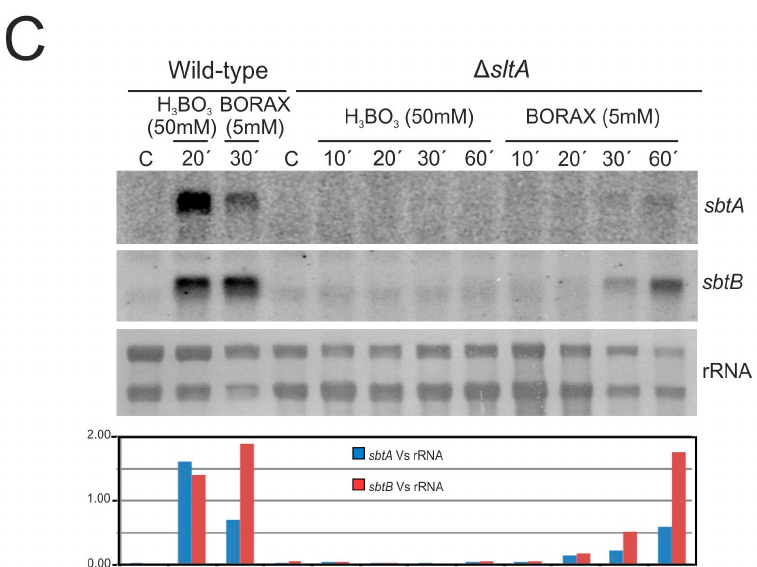
Figure 6. Transcriptional control of sbtA/B expression by SltA. Northern-blot experiments showing: ( A ) expression of sbtA and sbtB in a wild-type strain after 10, 20, 30 or 60 min of cultivation in medium with 50 mM boric acid or 5 mM Borax, ( B ) null expression of sbtB in a wild-type background after 10, 20, 30 or 60 min of culture in medium with 25 mM sodium bicarbonate ( enaA and An 8956, two of the most upregulated genes in medium with bicarbonate, were used as positive controls), and ( C ) downregulation of sbtA and sbtB expression in medium with boric acid (50 mM) or Borax (5 mM) in a ∆ sltA background. Ribosomal RNA (rRNA) levels are shown as loading controls in all panels. The graphs below each Northern-blot show the ratios between the average pixel intensity (quantified using open-source ImageJ software (National Institutes of Health, Bethesda, MA, USA) of each Northern-blot band and the corresponding rRNA (large subunit) band.